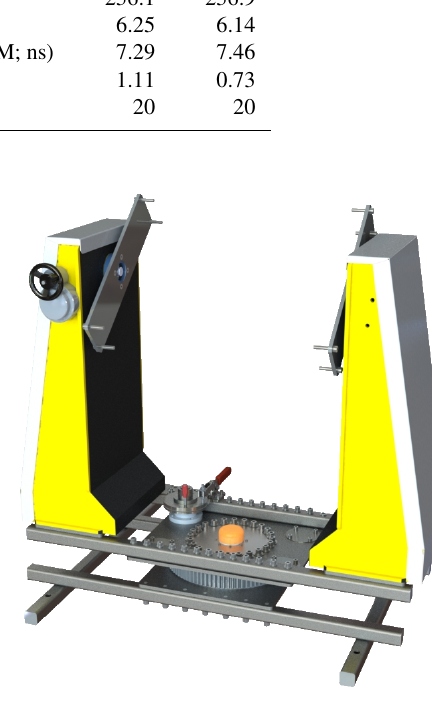
Figure 5. The fork-type positioner of the lidar